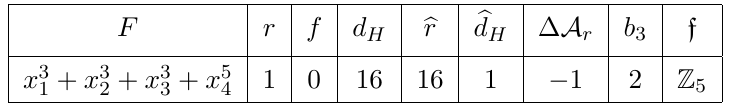
+ x 3 + x 3 + x 5 = 0 1 2 3 4